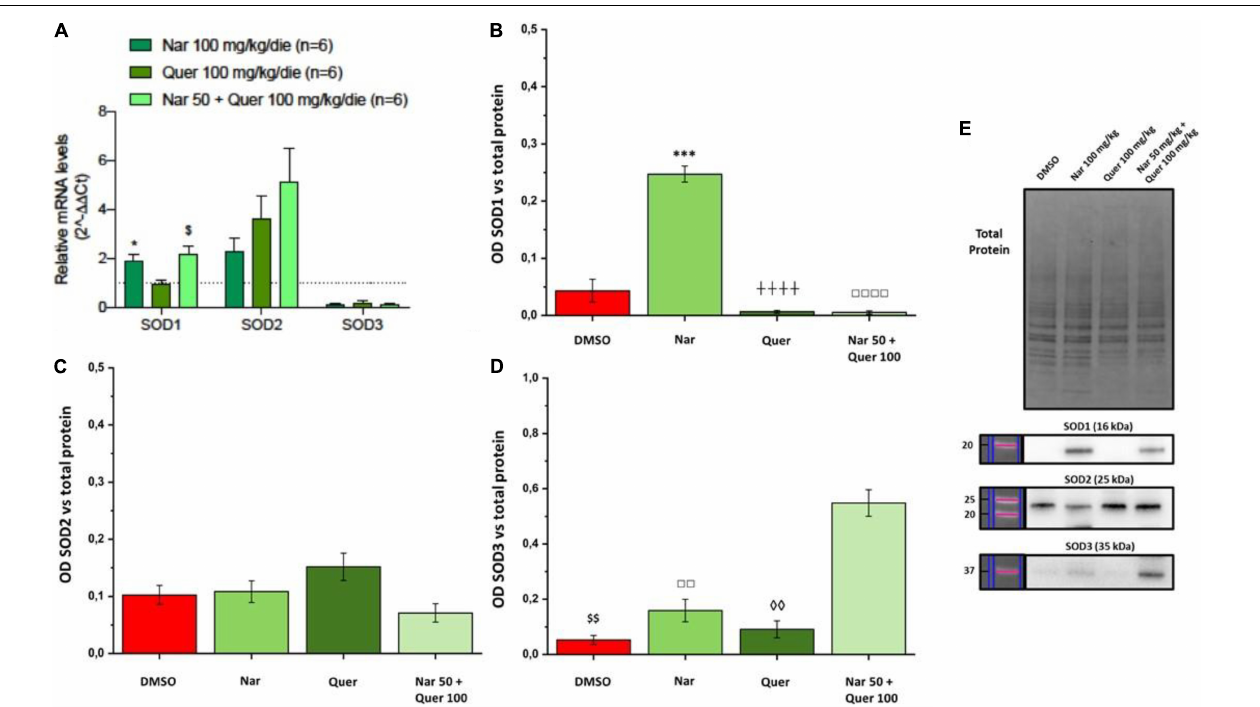
FIGURE 7 | Real-time PCR and WB analysis of oxidative stress markers. (A) Trend and statistical significance of transcriptional expression of Sod1, Sod2, and Sod3 genes (data from array analysis) in groups treated with naringenin 100 mg/kg/day, quercetin 100 mg/kg/day, and naringenin 50 + quercetin 100 mg/kg/day ( n = 6, respectively) compared to the control group ( n = 6). The data are extrapolated from the array analysis and are representative of six animals ± SEM. Bars represent the value obtained after normalization of each value on the mean expression of the most stable genes among those analyzed (from array analysis). The data are expressed as fold-change relative to the control group (made = 1). The statistical analysis was performed using Student’s t -test of the normalized values for each gene in treatment groups ( ∗ p ≤ 0.05, naringenin 100 group vs. DMSO group; $ p ≤ 0.05, naringenin 50 + quercetin 100 group vs. DMSO group). (B–D) Quantification by WB of the protein levels of Sod1, Sod2, Sod3 in the groups treated with naringenin 100 mg/kg/day ( n = 10), quercetin 100 mg/kg/day ( n = 6) and naringenin 50 + quercetin 100 mg/kg/day ( n = 4) compared with the control group (DMSO, n = 6). (E) Image of the bands related to Total Protein, Sod-1, Sod-2, and Sod-3. The data are representative of animals ± SEM. The bars represent each value normalized with the total protein and then compared with the control group (DMSO only); statistical analysis was performed using one-way ANOVA test followed by Bonferroni test ( ∗∗∗ p ≤ 0.001, naringenin 100 group vs. DMSO